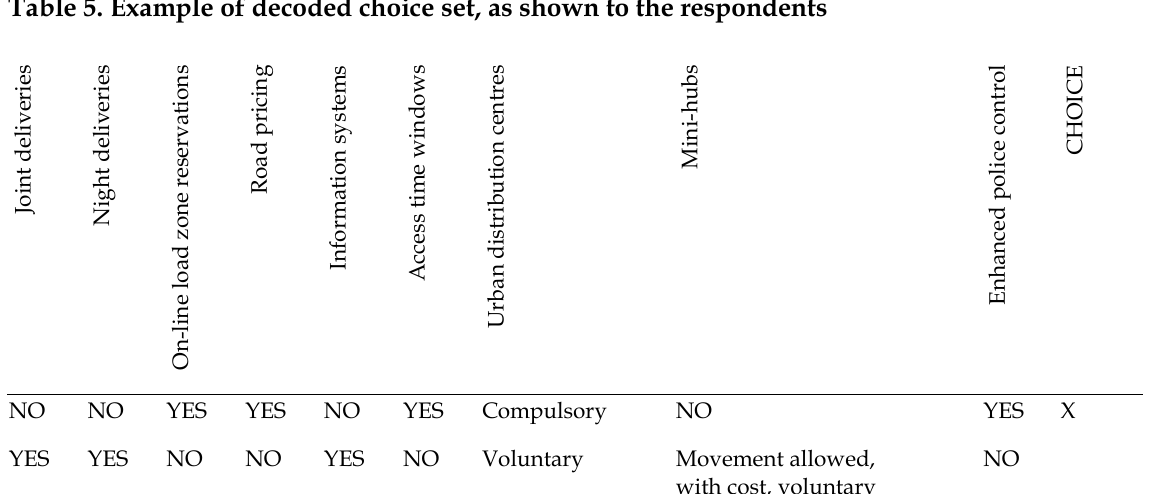
Table 5. Example of decoded choice set, as shown to the respondents